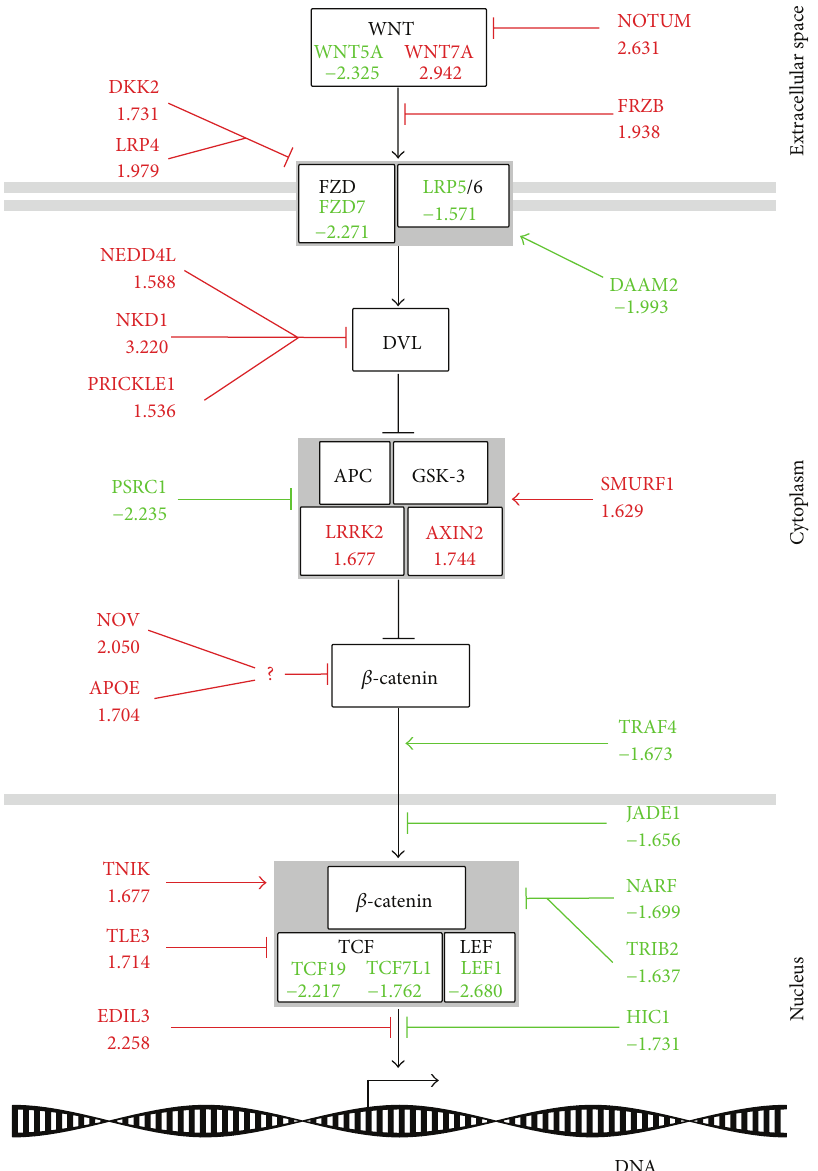
Figure 2: Detected regulatory influences on the canonical Wnt pathway. Scheme of the canonical Wnt pathway. Pointy arrowheads indicate an activating, blunt arrowheads, an inhibitory influence. The fold-change in expression of genes is written under the respective gene acronyms and colours indicate a general upregulation (red) or downregulation (green). For detailed explanation of the signalling cascade and regulated genes, see